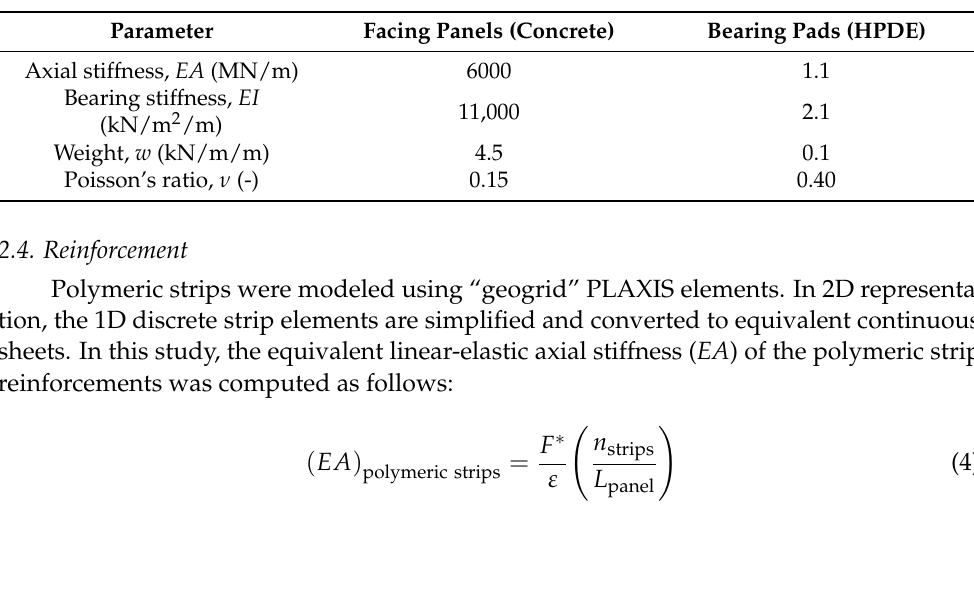
Road Pavement Foundation